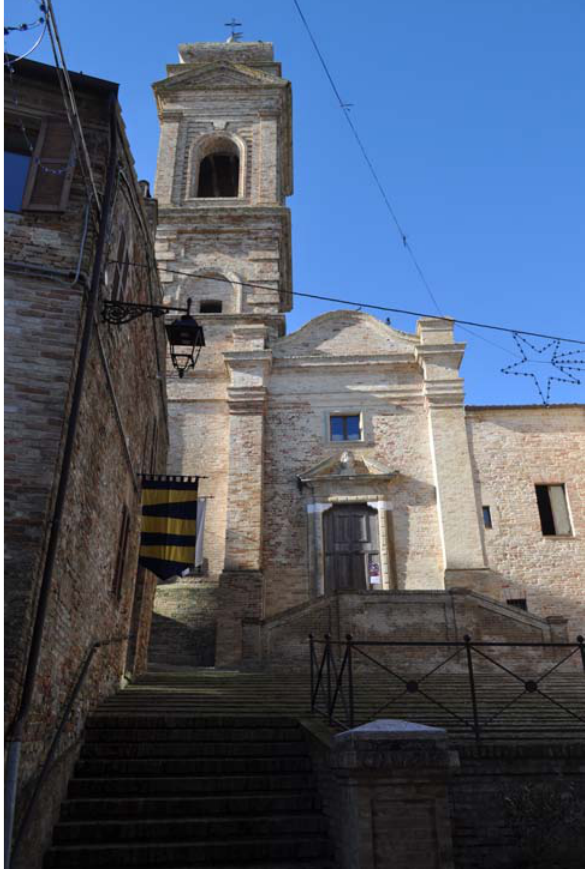
Figure 1. Front of the church with the monumental